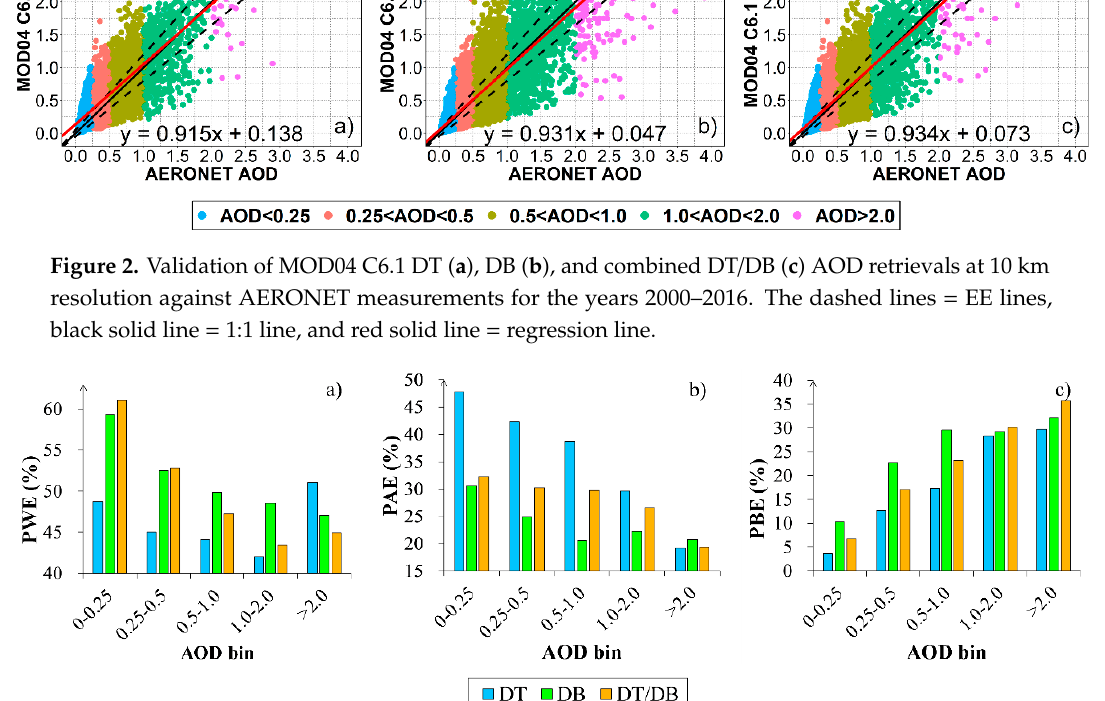
Figure 3. The percentage within in (PWE), above (PAE) and below (PBE) the expected error for the